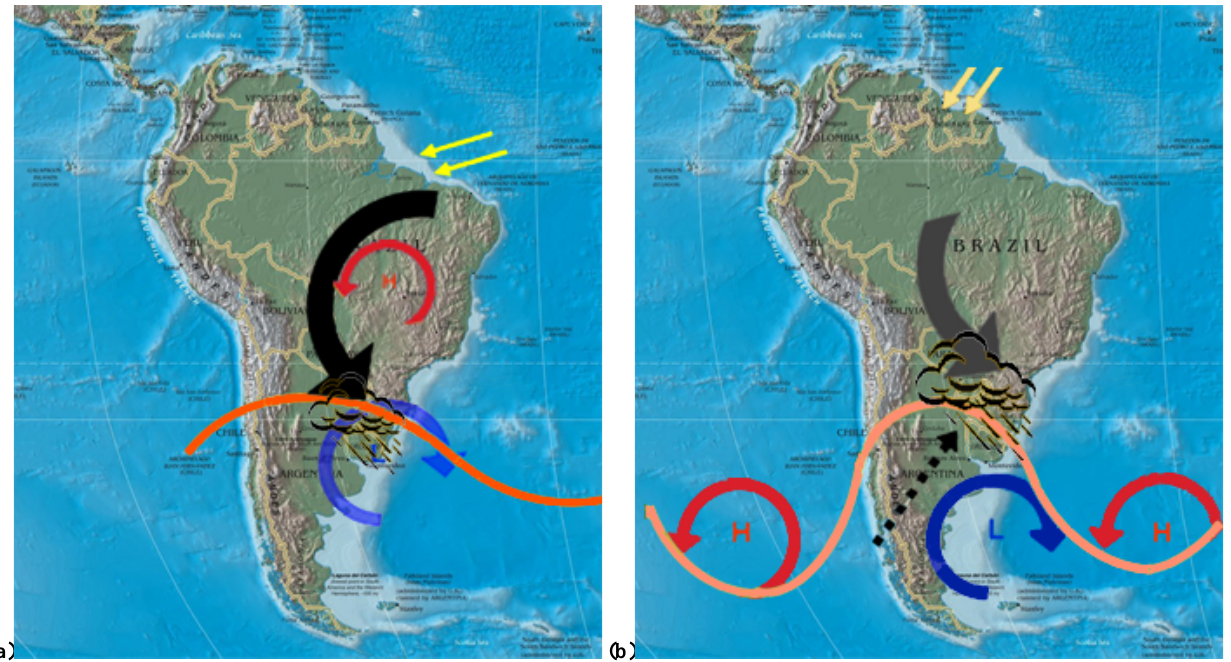
Fig. 7. Conceptual diagram on the physical mechanisms that may modulate the spatial and temporal variability of the SALLJ during the austral summer of (a) El Ni˜no and (b) La Ni˜na events. The yellow and black arrows indicate the trade winds and the SALLJ circulation that are more intense (darker arrow) in (a) than in (b). The H (red narrow) and the L (blue arrow) represents high and low pressures at 850hPa. In (b) the dotted black arrow indicates the southerly flow associated with the high and low pressures at 850hPa. The orange line shows the SJ at 200hPa where the dark color in (a) indicates a much stronger intensity than in (b). The cloud represents the main precipitation